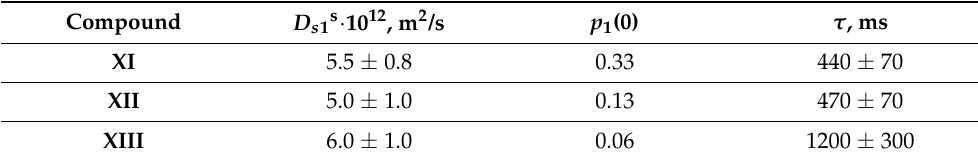
Table 6. The self-diffusion coefficients D s 1s , population p 1 at t d → 0 , p 1 (0), and lifetimes τ of WSFD molecules in RBCs. Reprinted with permission from Ref.